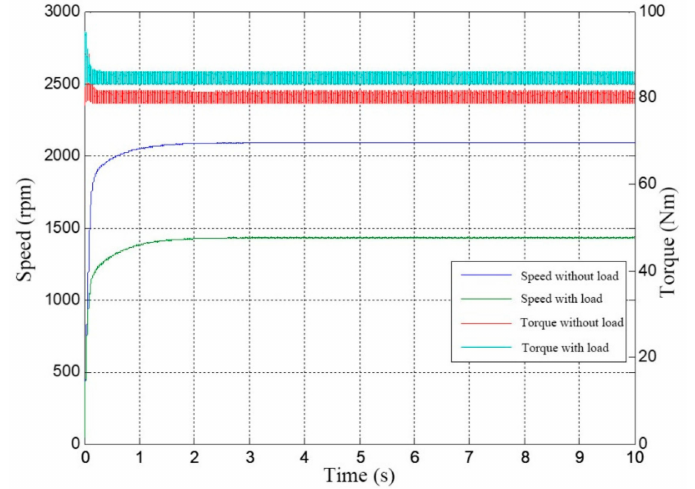
Figure 13. The speed and torque of the SRM during the travelling